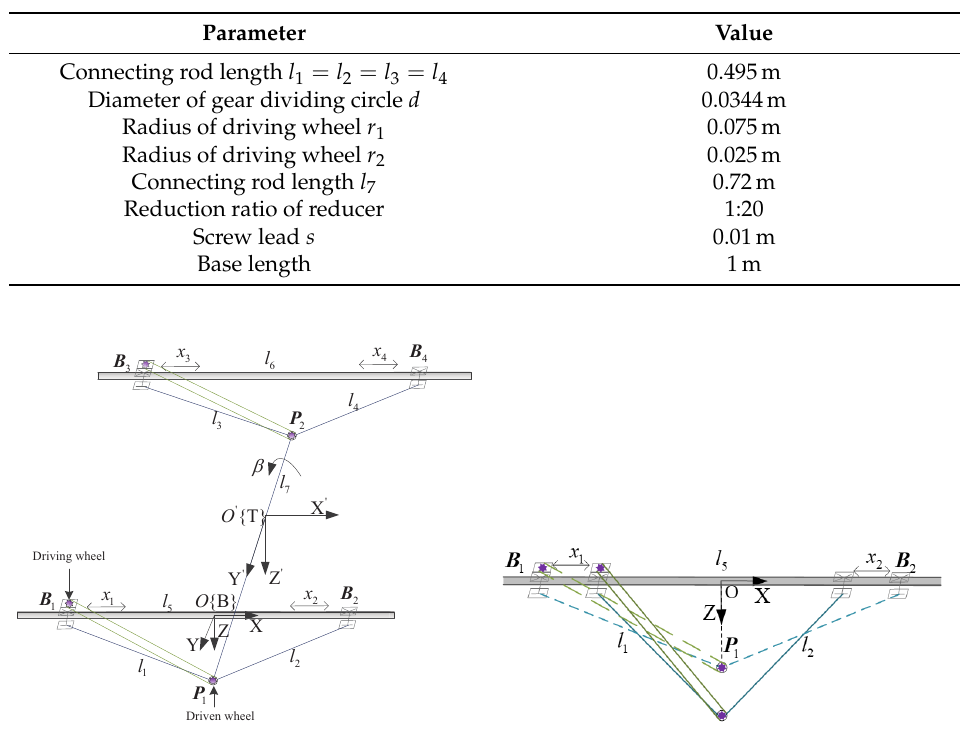
Figure 2. Structural sketch and side view of the